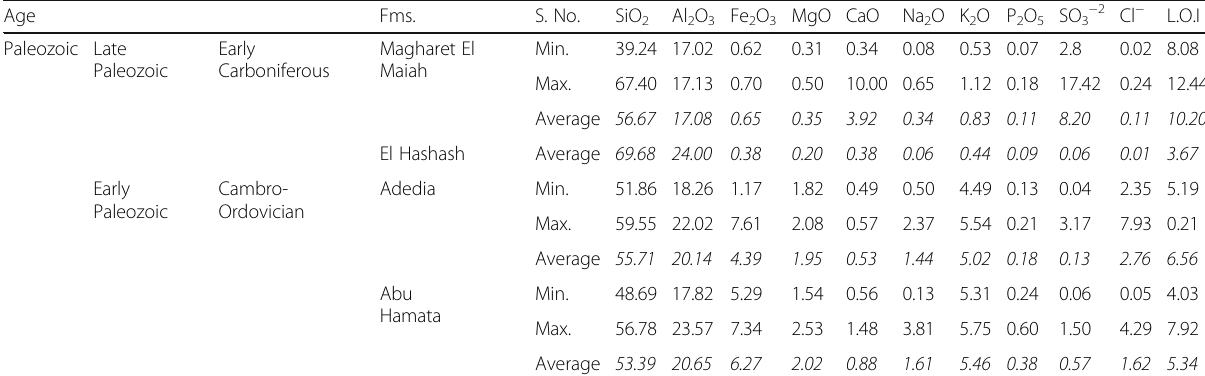
Table 3 Average chemical composition (major components in wt.%) of Paleozoic mudrocks Age Fms.